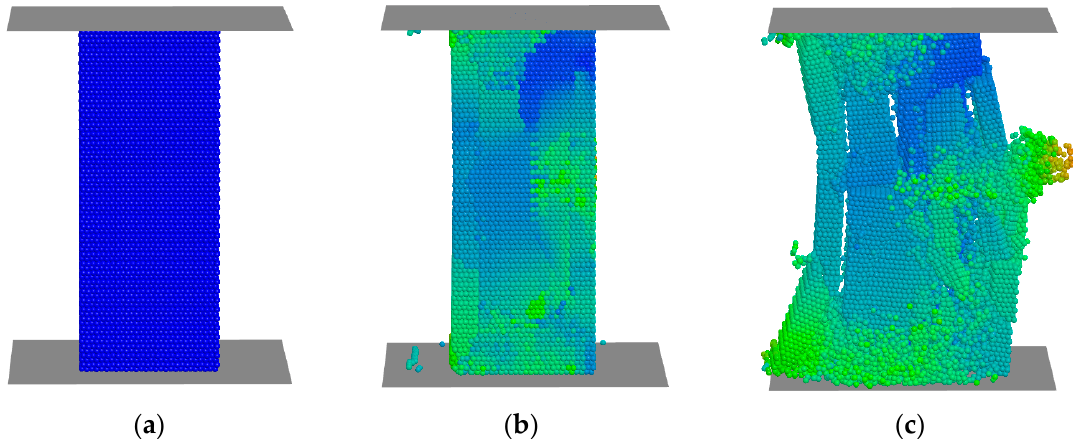
Figure 4. Uniaxial compression test of sea ice by DEM simulation: ( a ) t = 0.0 s; ( b ) t = 0.05 s; ( c ) t = 0.1 s.